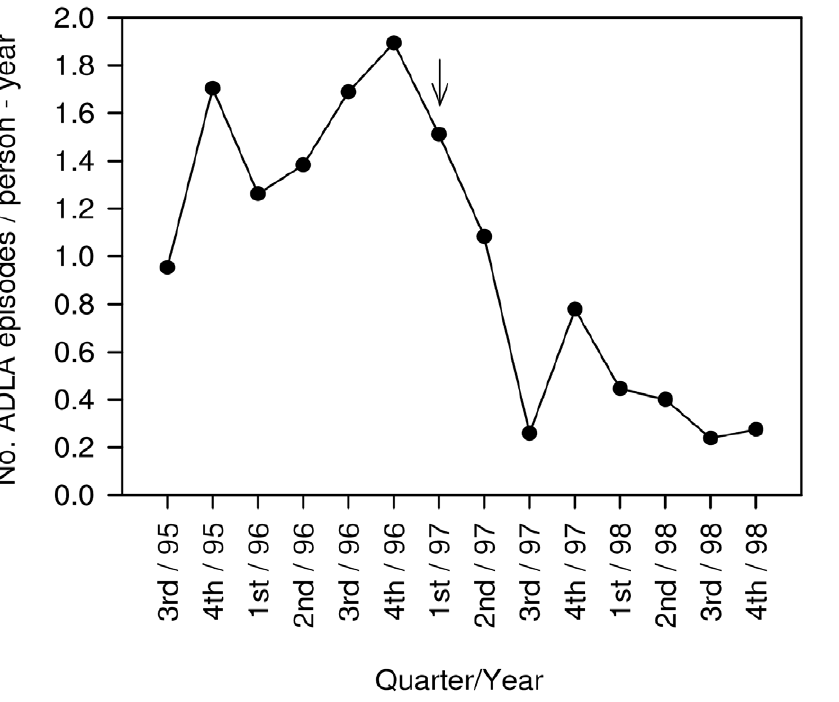
Figure 1. Quarterly incidence of acute dermatolymphangioadenitis (ADLA) in 175 lymphedema patients, 1995–1988, Leogane, Haiti. Arrow indicates the point at which the program focus shifted away from decreasing leg volume using compression bandages to reducing the frequency of ADLA through hygiene, skin care, range-of-motion exercises and leg elevation.